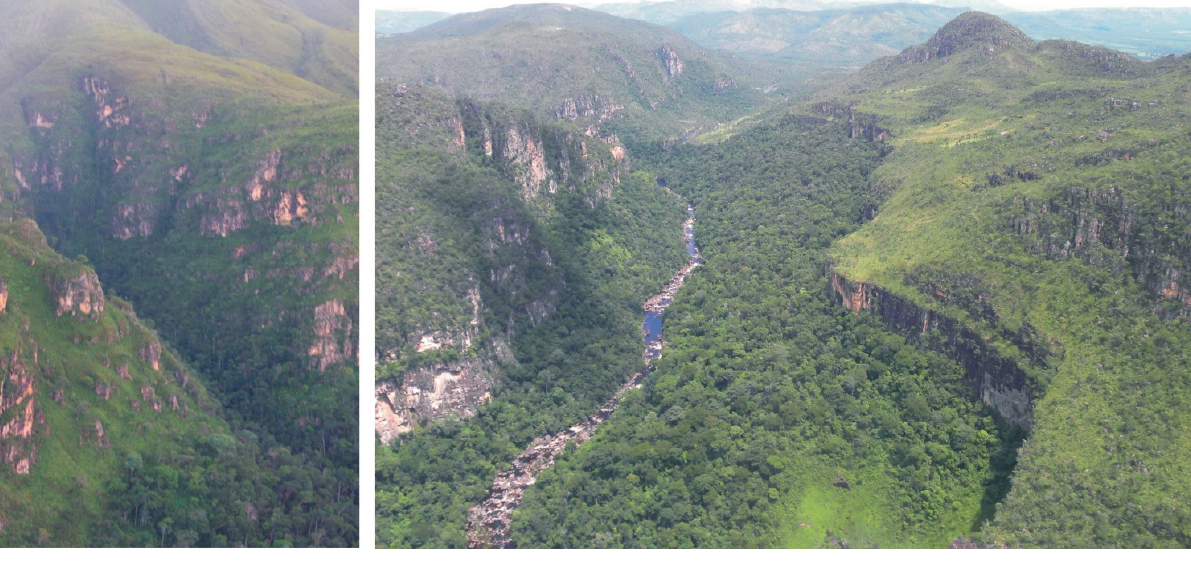
Figure 4. Panoramic photographs of the Closed Savanna Woodland in the Chapada dos Veadeiros National